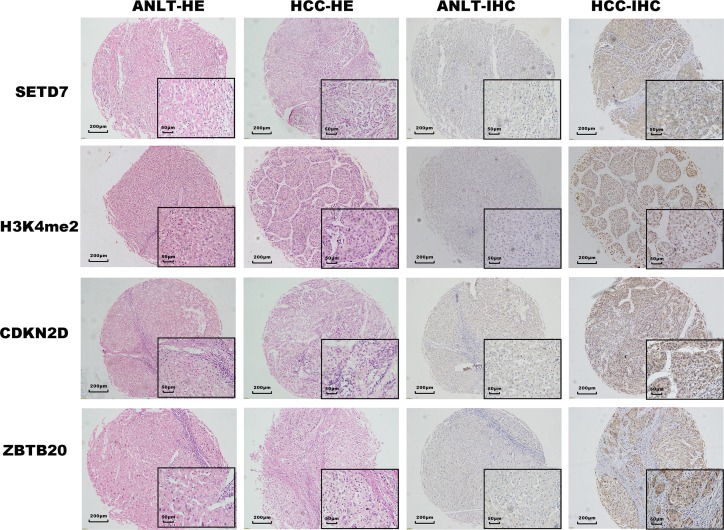
SETD7, H3K4me2, ZBTB20, and CDKN2D level in HCC was determined by TMA IHC.The two rows on the left indicate HE staining for HCC tumor tissues and paired ANLTs, whereas the two rows on the right indicate IHC staining for SETD7, H3K4me2, ZBTB20, and CDKN2D protein in HCC tumor tissues and paired ANLTs (n = 225). (Original magnified 100×; Inserted figures magnified 400×).